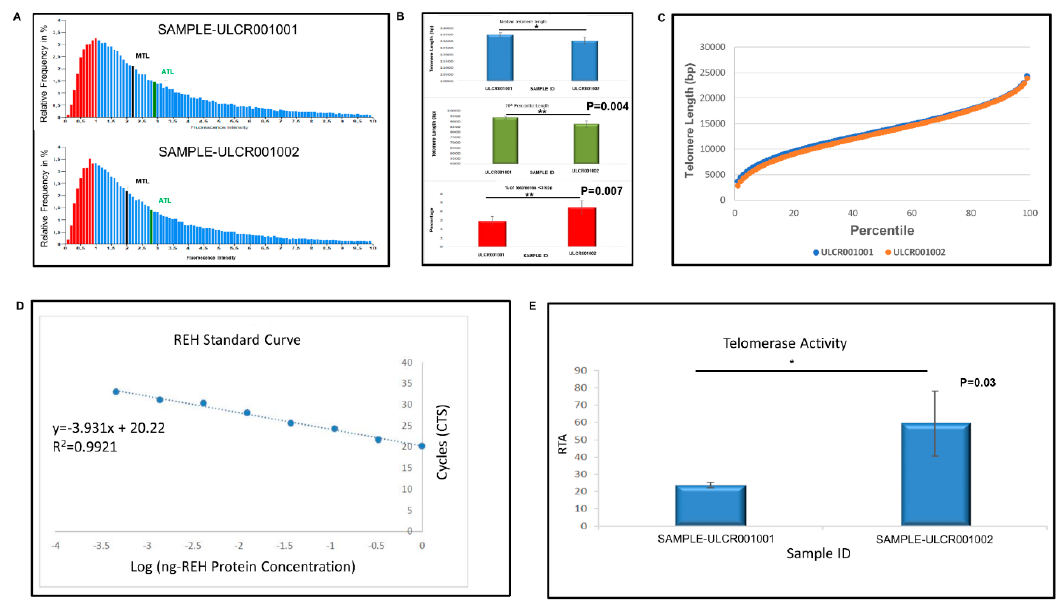
Figure 6. Distribution of telomere lengths in fresh and passaged iPSCs. ( A ) Bars represent the relative frequency for every particular fluorescence intensity normalized (X axis). The 20th percentile (red bars) indicates the particular length below which 20% of the telomeres were observed. The median (MTL) and average telomere length (ATL) are also indicated in the histogram. The relative frequency distribution along the X axis allowed for the analysis of telomere length variability. ( B ) Telomere analysis technology (TAT) results (median telomere length, 20th percentile telomere length, and % short telomeres) for both samples. ( C ) Comparison of percentile curves for both samples. ( D ) Standard curve of Ct values of protein from cells against log of protein (ng). The cycle number at the threshold (Ct value) for each sample was interpolated in the curve in order to calculate relative telomerase activity (RTA). ( E ) Quantitative telomeric repeat amplification protocol (Q-TRAP) results (RTA) for two samples.